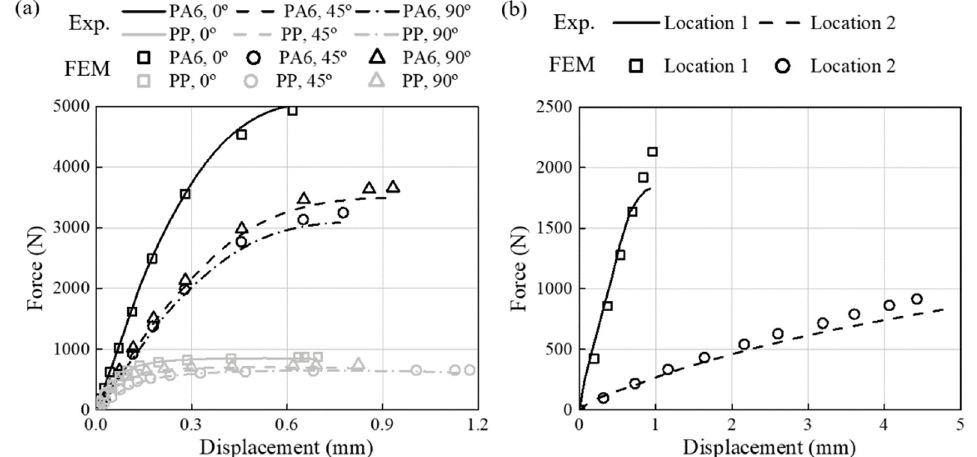
Figure 14. Load-displacement curves (line: experimental data, scatter: FEM results). ( a ) PA6-CF and PP-CF materials for the uniaxial specimens. ( b ) Cross-member specimens.